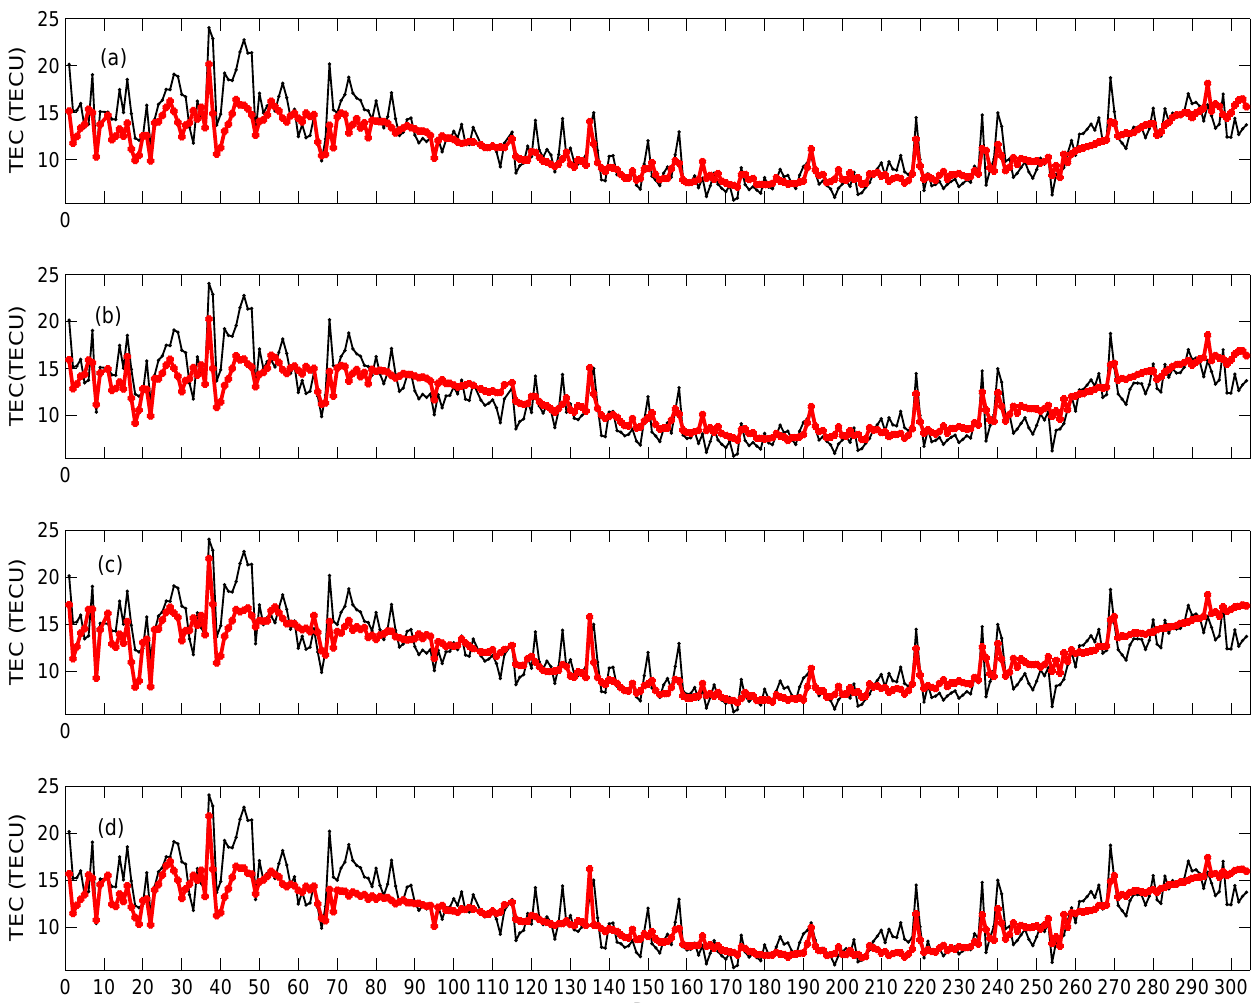
Fig. 10. Comparison between average daily GPS TEC (thin black line) and the corresponding predictions (thick red line); (a) T (S p ), (b) T (S p , B z ), (c) T (S p , N p ) and (d) T (S p , V sw ); for the verifying year